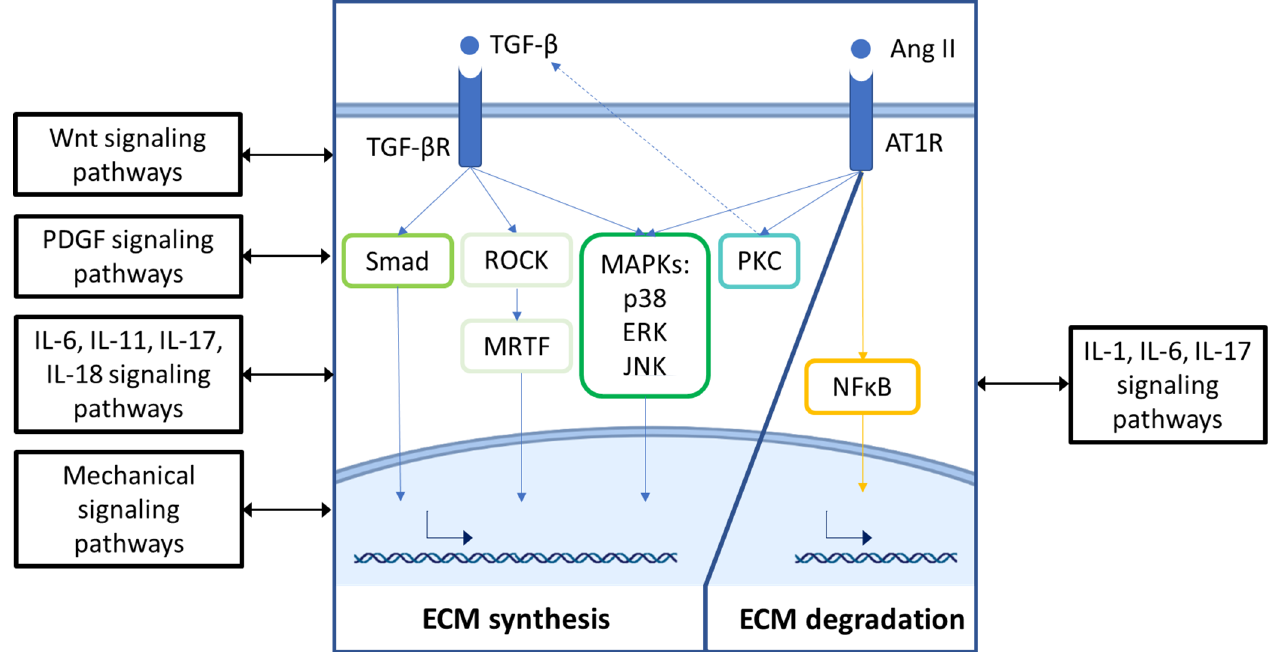
Figure 3. Signaling pathways that drive extracellular matrix remodeling in cardiac fibroblasts and vascular smooth muscle cells. Many signaling pathways that induce changes in gene expression, such as Wnt, Platelet-Derived Growth Factor (PDGF), interleukin (IL)-1, IL-6, IL-11, IL-17 and IL-18, and mechanical signaling, do so by affecting Transforming Growth Factor (TGF)- β and Angiotensin (Ang) II signaling. TGF- β and Ang II will, in turn, affect gene expression leading to extracellular matrix (ECM) synthesis or degradation through their multiple, and overlapping, downstream signaling pathways. Thus, TGF- β and Ang II are central in regulating the homeostasis of ECM turn- over. NF ĸ B, nuclear factor kappa B; PKC, protein kinase C; MAPK, Mitogen-Activated Protein Ki- nase; ERK, Extracellular signal-regulated kinase 1/2; JNK, Jun N-terminal kinases; MRTF, Myocar- din-Related Transcription Factor, ROCK, Rho-associated protein kinase; Smad, Suppressor of Moth- ers against Decapentaplegic.